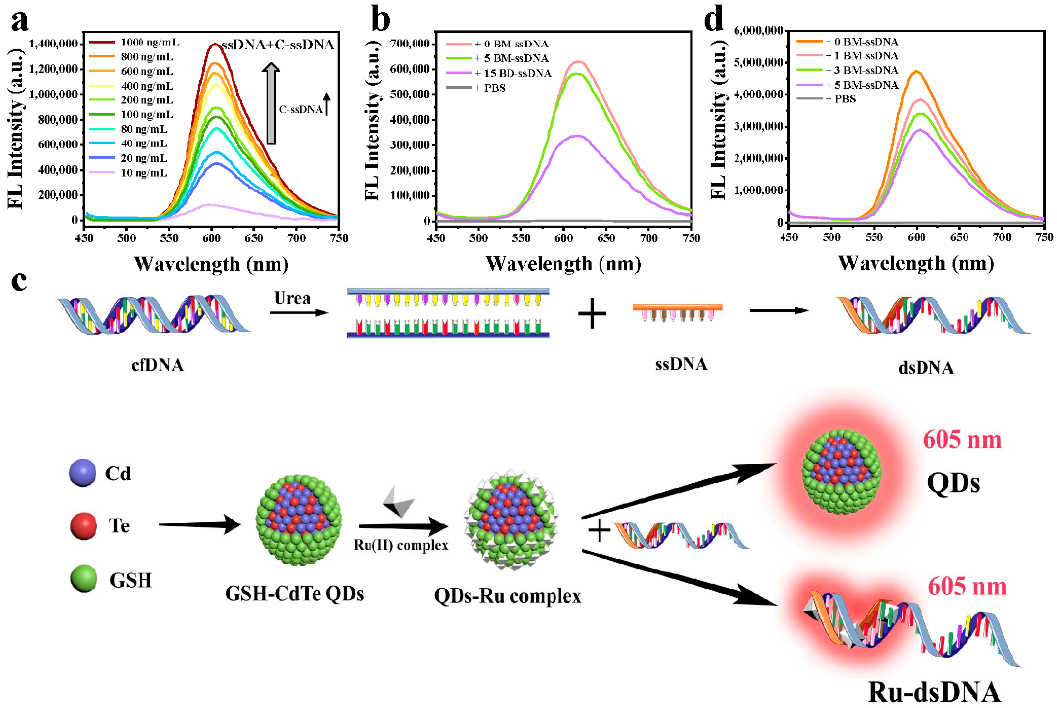
Figure 4. The specificity and mechanisms of the clutch probe. ( a ) The fluorescence of QDs is recovered with the increase of complementary ssDNA’s (C-ssDNA) concentrations. ( b ) The fluorescence spectra of QDs and Ru-DNA complexes after interaction with different complementarity of two ssDNA (0BM-ssDNA: fully complementary ssDNA; 5BM-ssDNA: 5 bases mismatched ssDNA; 15BD-ssDNA: 15 bases deleted ssDNA). ( c ) Mechanism of specific recognition by fluorescent probes. ( d ) The fluorescence spectra of QDs and Ru-DNA complexes after interaction with different complementarity of Cas9 plasmid L-dsDNA and specific Cas9 plasmid L-ssDNA (0BM-ssDNA: fully complementary ssDNA; 1BM-ssDNA: 1 base mismatched ssDNA; 3BM-ssDNA: 3 bases mismatched ssDNA; 5BM-ssDNA: 5 bases mismatched ssDNA).